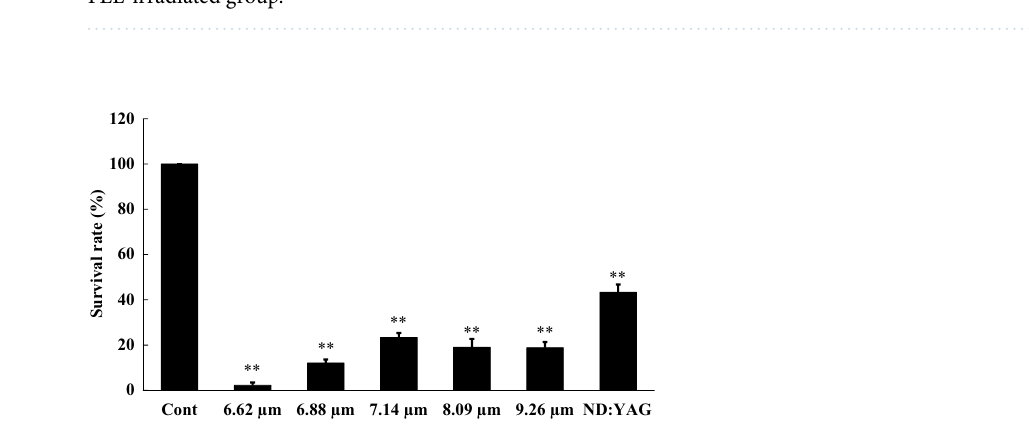
Table 2. Changes in the number of CFUs induced by MIR-FEL or Nd: YAG irradiation of E. coli. Data are shown as the mean ± SD of 1 × 10 7 CFUs/mL. Asterisks indicate significant differences ( P < 0.01) from the control (non-irradiated group), and daggers indicate significant differences ( P < 0.01) from the 6.62 µm MIR- FEL-irradiated group.